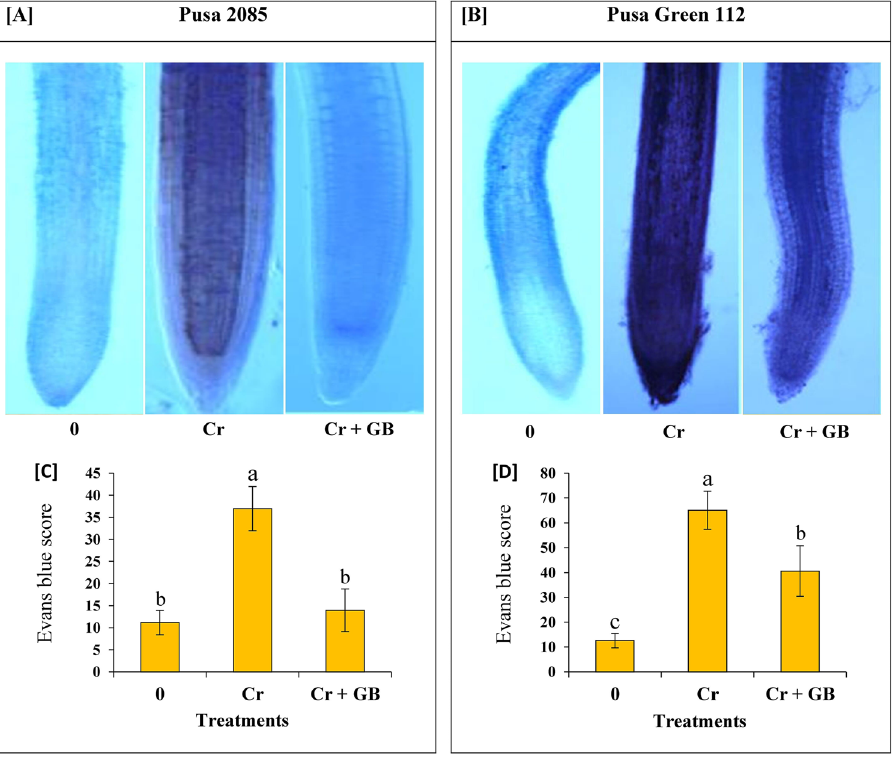
Figure 3. The loss of plasma membrane integrity (PMI) in the root tips of both chickpea cultivars, ( A ) Pusa 2085 and ( B ) Pusa Green 112 grown under hydroponics conditions for 7 days in the presence of different levels of glycine betaine (GB) and chromium (Cr): 0 and 120 µM Cr and 120 µM Cr + 100 mM (GB). Microscopic images of the roots from stressed and non-stressed plants stained with Evans blue. ( C,D ) Evans blue score in the root tips. The generated data values are shown as the mean of five replicates ± SE. The error bars indicated by the different letters represent significant differences, as tested by the least significant difference test (p < 0.05).